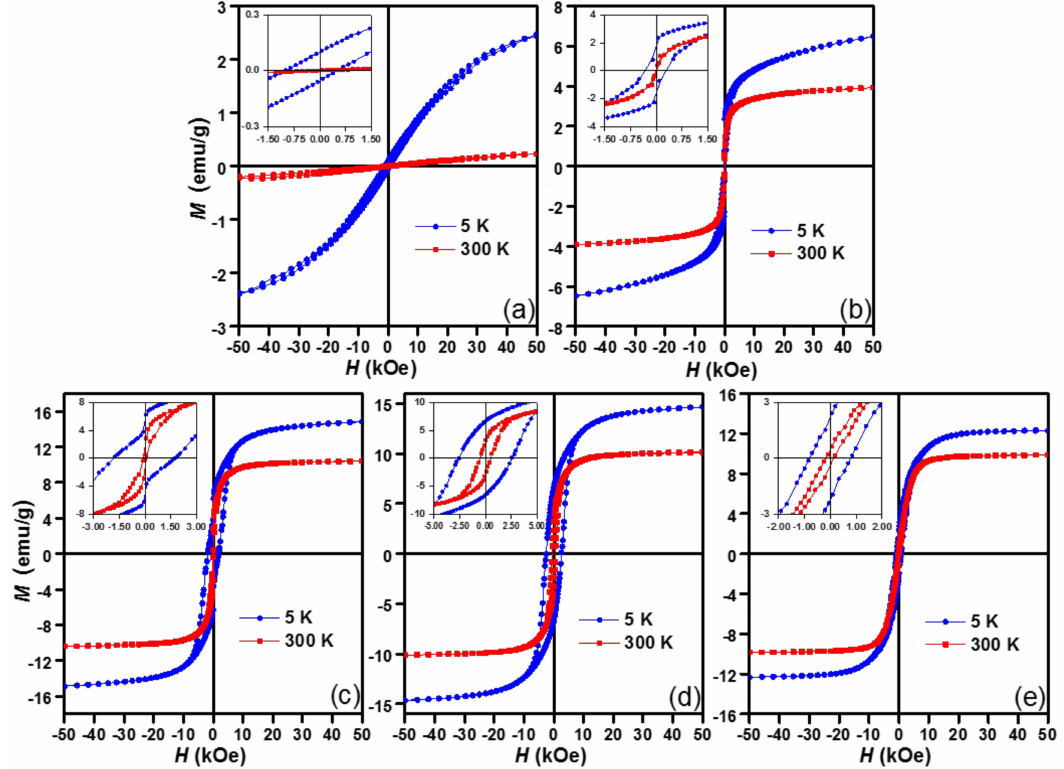
Figure 5. Isothermal M vs. H loops of the CP ( a ); NHD-600 ( b ); NHD-750 ( c ); NHD-900 ( d ) and NHD-1050 ( e ) samples collected at RT (red squares) and 5 K (blue circles). The insets show the detailed features of the loops around H =